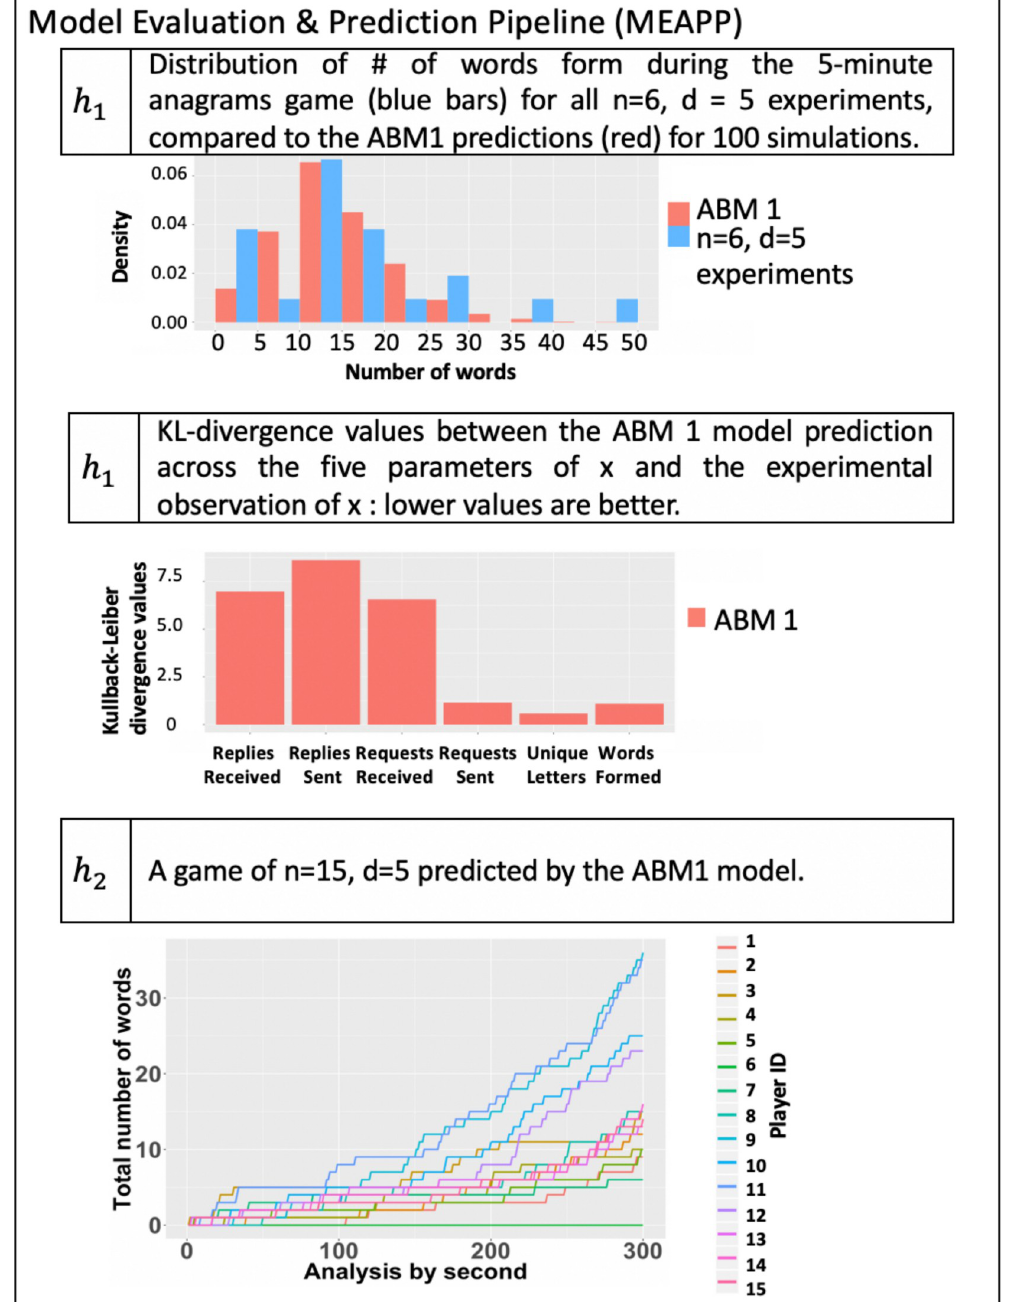
Fig 18. The Modeling And Simulation Pipeline (MASP) and Model Evaluation And Prediction Pipeline (MEAPP) were run to obtain simulation results and model predictions, and to compare experimental data to model predictions. All three plots contain model predictions and use results from h 1 of the MASP. Function h 1 of MEAPP plots corresponding experimental and model output data (top plot) and compares experiment and model output using KL-divergence (center plot) for six parameters. Function h 2 of MEAPP uses h 3 of the Data Analysis pipeline (DAP) to plot model predictions from h 1 of the MASP (bottom plot) where now n = 15 (in experiments, n = 6).